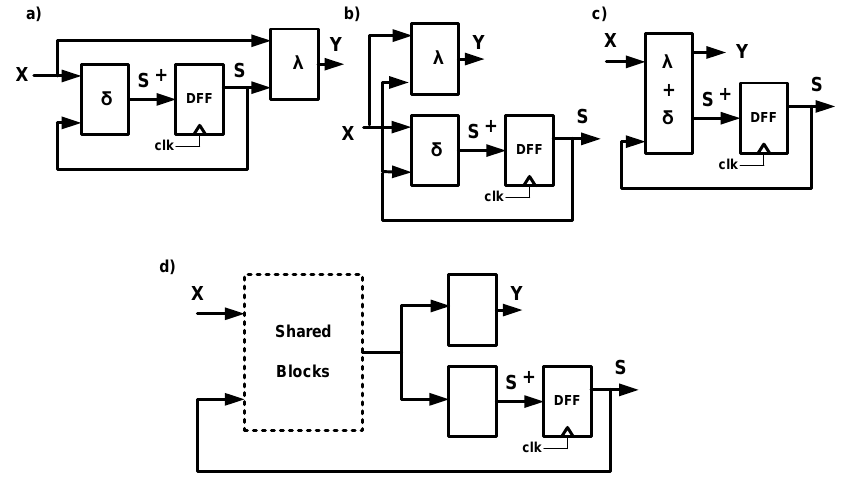
Figure 8. The idea of carrying out FSM using sharing of logic resources: ( a , b ) FSM form in which both combination blocks are shown separately, ( c ) FSM form in which both combination blocks are presented together, ( d ) FSM form in which the combined block has a shared block.